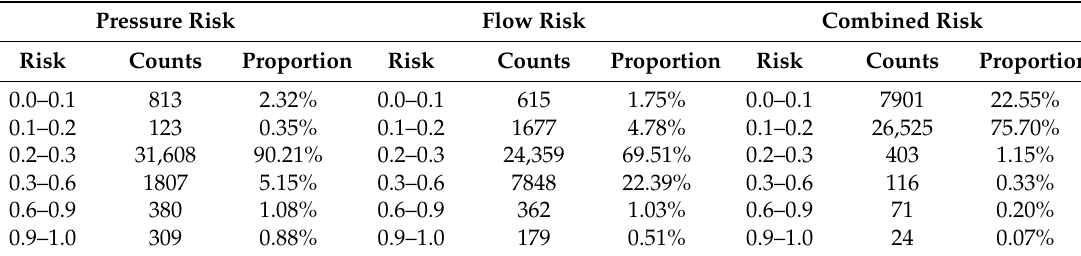
Table 1. Counts and proportion of data in different risk